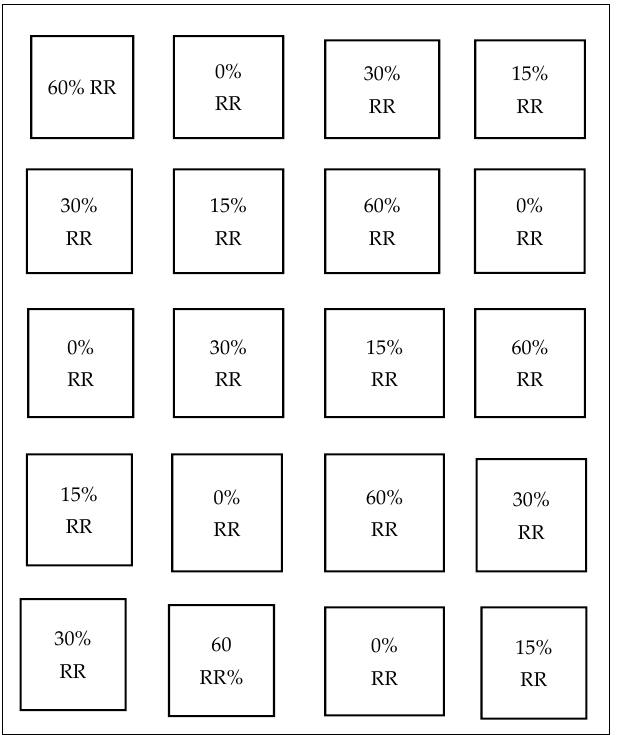
Figure A1. Sketch of the experimental layout at the university of pretoria experimental farm.